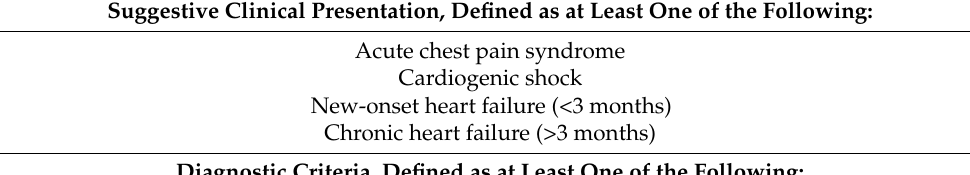
Table 2. Definition of clinically suspected myocarditis according to the European Society of Cardiology. Suggestive Clinical Presentation, Defined as at Least One of the